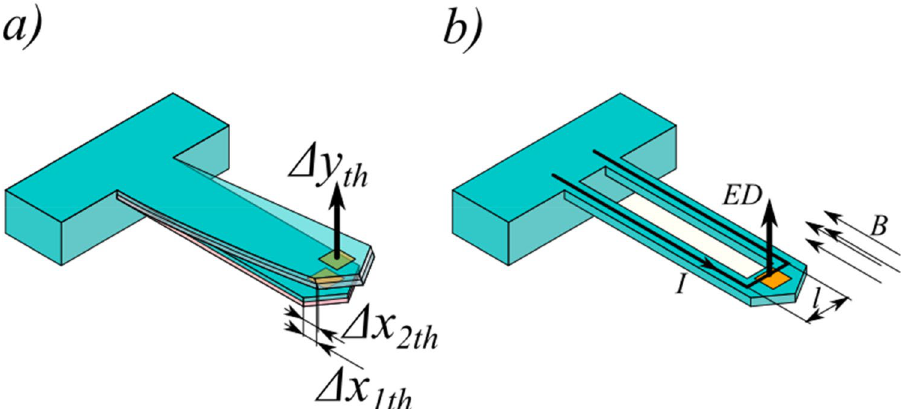
Figure 6. Actuations: ( a ) thermomechanical and ( b )